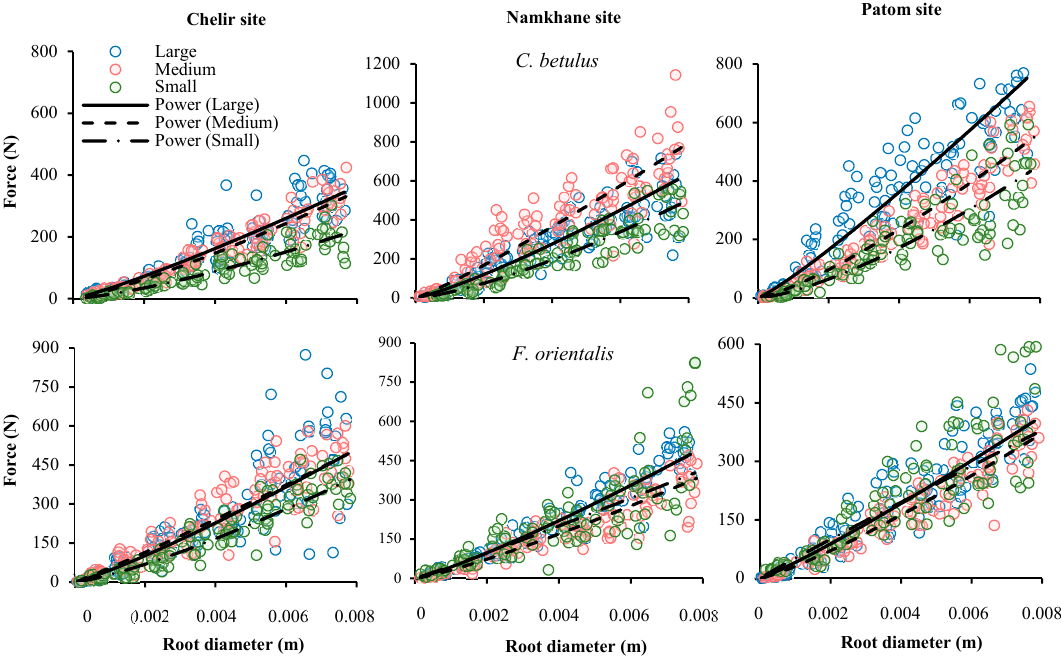
Figure 8. Tensile force at failure point versus root diameter for diameter at breast height (DBH; small = 7.5–32.5 cm; medium = 32.6–57.5; and large = 57.6–82.5 cm) at three study sites (Chelir, Namkhane, Patom) for Carpinus betulus and Fagus orientalis . Solid (large), dashed (medium), and long dash dot (small) lines show power-law regression curves fitted to the data.